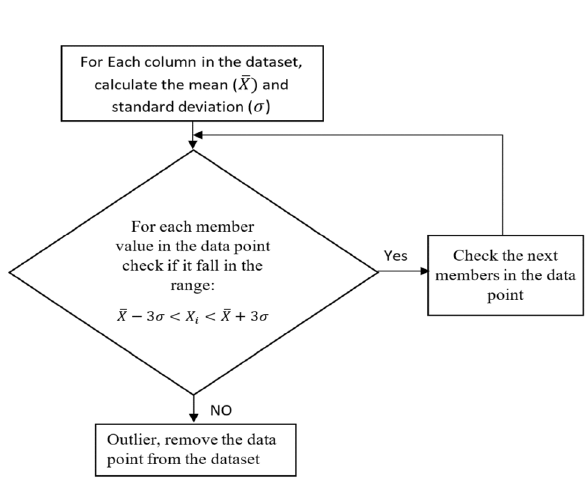
Fig. 3 Outliers’ detection